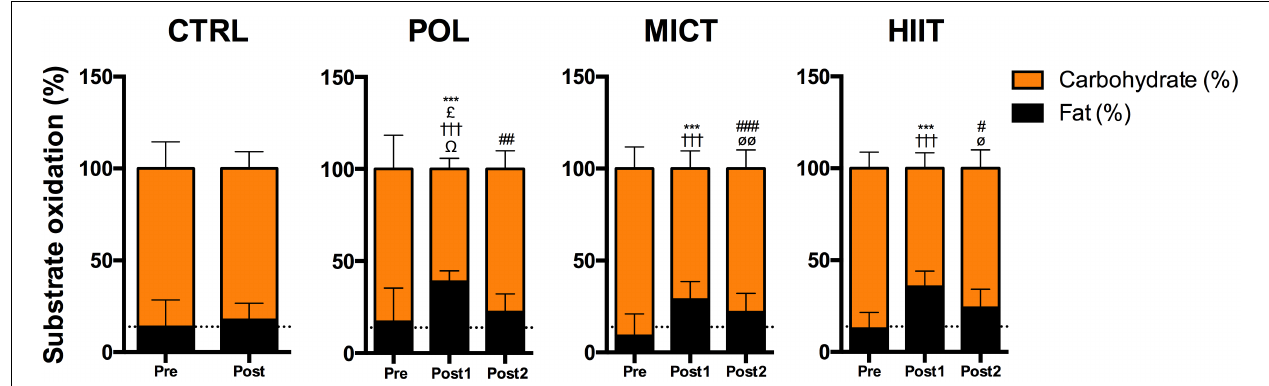
FIGURE 5 | Effects of training intervention on whole-body substrate utilization during a cycling trial at 60% of pVO 2 peak. Relative energy expenditure (%) from fat and carbohydrate oxidation before and after 12-weeks of control (CTRL), polarized volume training (POL), moderate-intensity endurance training (MICT), and high-intensity interval training (HIIT). Data are shown as mean ± SD. ∗∗∗ Denote differences between Pre and Post-1 values for fat oxidation (time effect: p < 0.001). £ Denote differences in fat oxidation for Post-1 values between POL vs. CTRL group after intervention (training effect: p < 0.05). # , ## and ### Denote differences between Pre and Post-2 values for fat oxidation (time effect: p < 0.05, p < 0.01, and p < 0.001, respectively). ††† Denote differences between Pre and Post-1 values for carbohydrate oxidation (time effect: p < 0.001). (cid:127) Denote differences in carbohydrate oxidation for Post-1 values between POL vs. CTRL group after intervention (training effect: p < 0.05). øø and ø denote differences between Pre and Post-2 values for carbohydrate oxidation (time effect: p < 0.001). The comparison was performed with Mixed Factorial ANOVAs with Bonferroni’s post hoc test for multiple comparisons. Post-1: 60% of pVO 2 peak of pre-training values. Post-2: 60% of pVO 2 peak according to the cardiorespiratory capacity after training